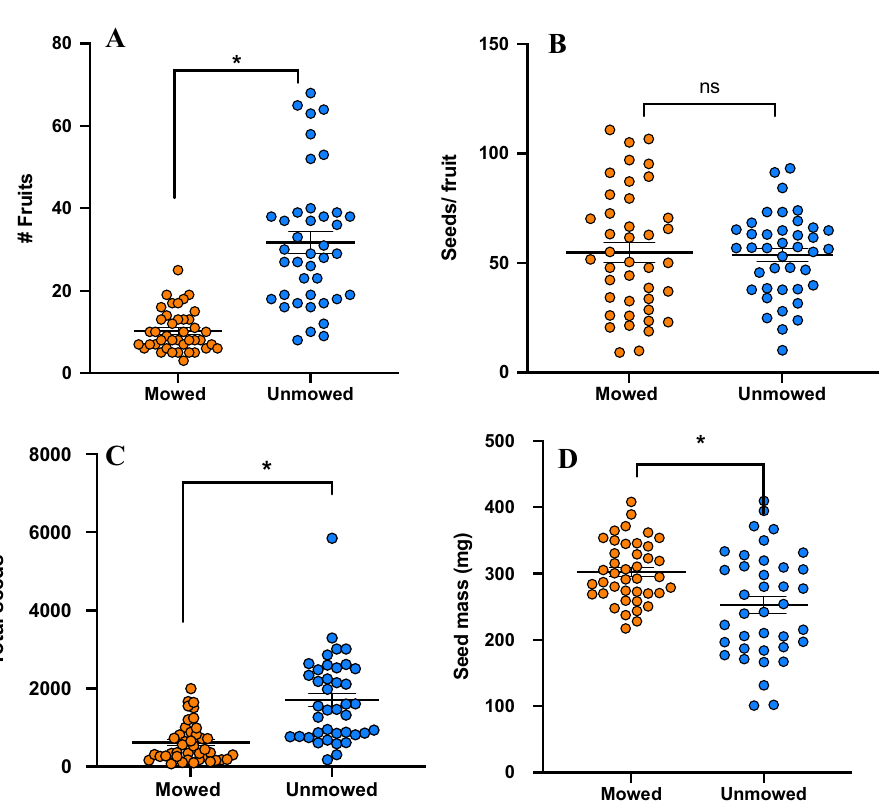
Figure 1. Results of field fitness traits ( A ) fruit set on mowed and unmowed locations (P < 0.001), ( B ) number of seed per fruit (Y-axis) (P = 0.809), ( C ) 100 seeds mass (Y-axis) (treatment P < 0.001), ( D ) total number of seeds (Y-axis) (P < 0.001). Means are shown by scale bars and asterisk denotes significantly different results at p < 0.05, while ns denotes non-significant